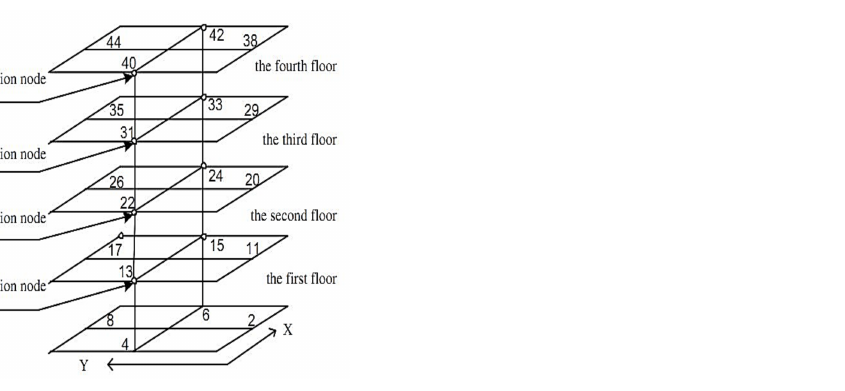
Figure 5. Location of all structure’s sensors and the sensors used in this research. The two types of Finite Element (FE) models with 12 and 120 degrees of freedom (DOF), respectively, are used to produce the time histories for pre-defined damage cases in Table 2 is used to test the performance of the proposed model. Table 2. Damage Cases of the Benchmark Model [45].